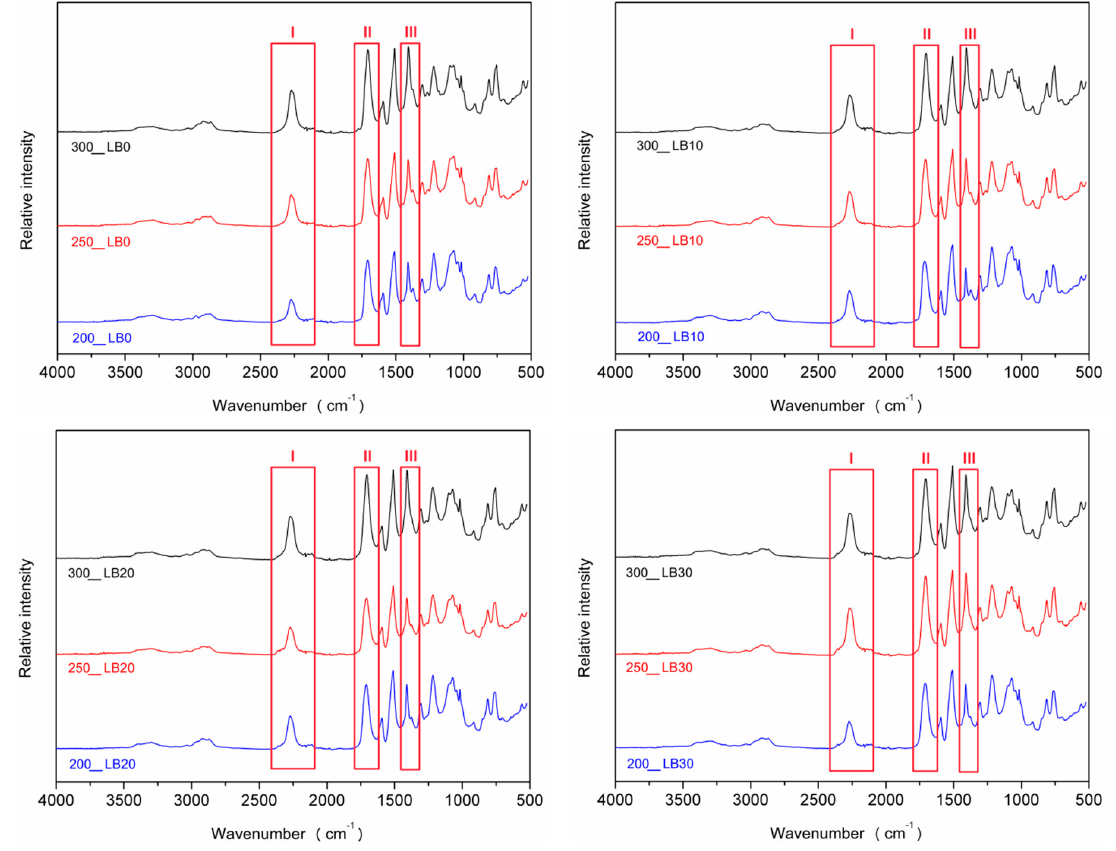
Figure 6. FTIR spectra of foams depending on I